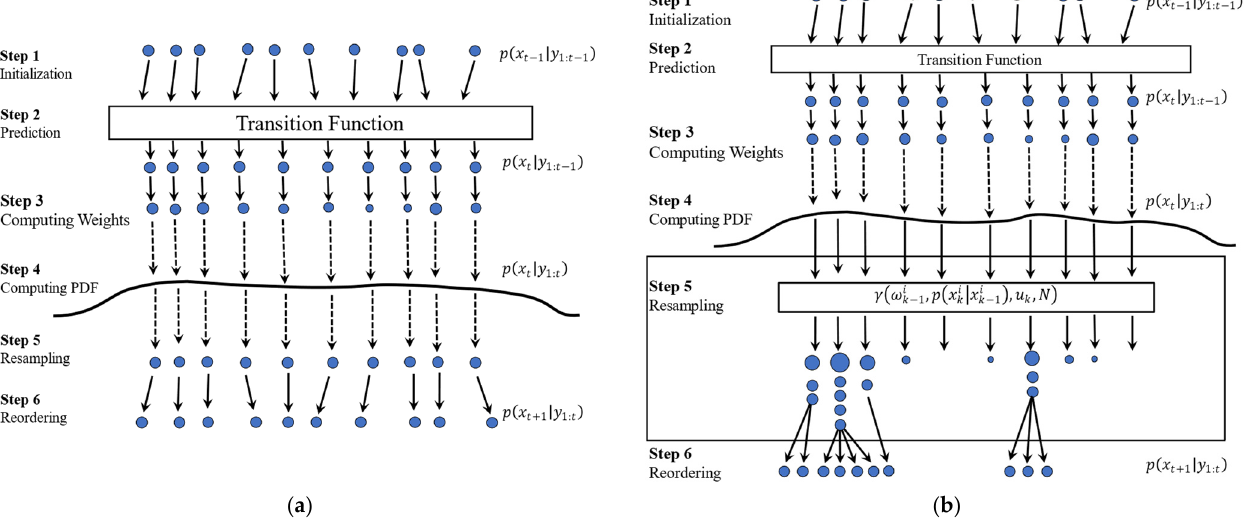
Figure 6. Comparison the steps associated with the ( a ) Particle Filter approach and the ( b ) Adaptive Particle Filter approach. (1) Particle initialization; (2) prediction; (3) computing weights; (4) computing PDF; (5) resampling; and (6) reordering.